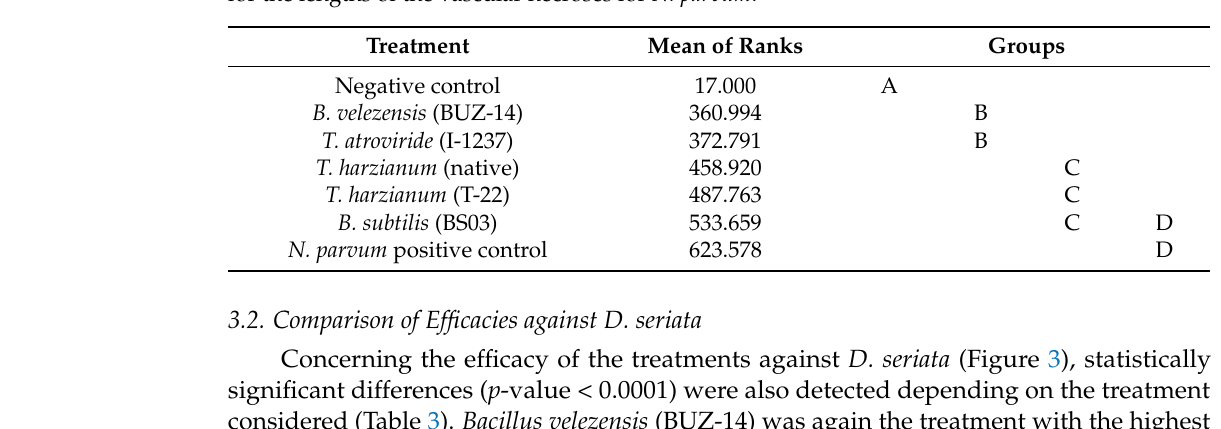
Figure 2. Box-plot of vascular necrosis lengths for N. parvum . Table 2. Kruskal–Wallis test and multiple pairwise comparisons using the Conover–Iman procedure for the lengths of the vascular necroses for N. parvum .